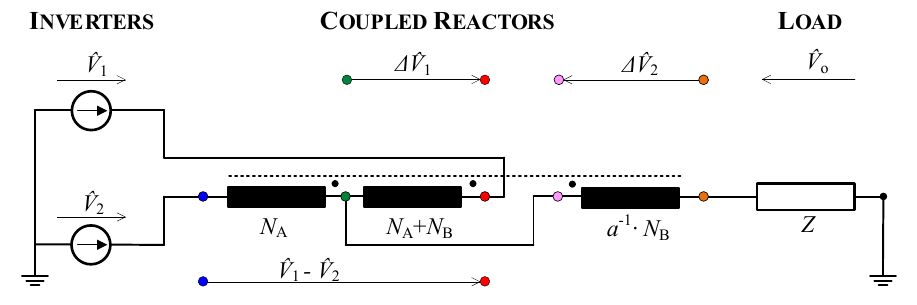
Figure 2. Vectorial equivalent circuit of the 12-pulse modular